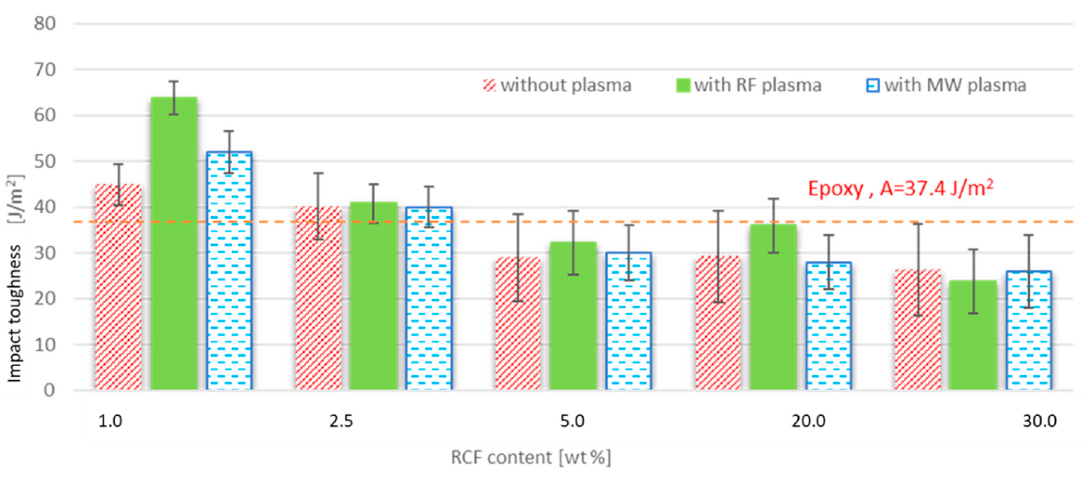
Impact toughness of FRE composites. The impact toughness results are shown in Figure 11. One of the possible disadvantages of using micro fillers in epoxy matrices is the potential formation of microscopic cracks. Microcracks in the materials can propagate under repeated loading or a combination of different loads and lead to the destruction of the composite, as pointed out by Teh [29]. If the measured values of the impact toughness of composites filled with recycled carbon fiber are compared with the impact toughness of pure resin (in Figure 11), the RCF plasma treatment improves the impact toughness of the samples with 1 wt% RCF. In contrast, plasma treatment of fibers has no significant effect on samples with high filler concentrations. Low-fiber concentrations (1 wt%–2.5 wt%) increased the tested composites’ impact toughness values compared to the unfilled resin’s impact toughness values. Compared to other studies [27–29], there was no stable increase in impact toughness values for the composites filled with recycled carbon fibers; the composites with the lowest filler concentration achieved the best results, while higher concentrations resulted in a deterioration of impact toughness compared to the impact toughness value of unfilled resin. This is probably due to the shape of the filler in the form of cylinders, and it may also be due to the formation of clusters after reaching a suitable fiber concentration. In contrast, at higher fiber concentrations, the influence of micro-layers reduces the impact toughness value, as also pointed out by [28].